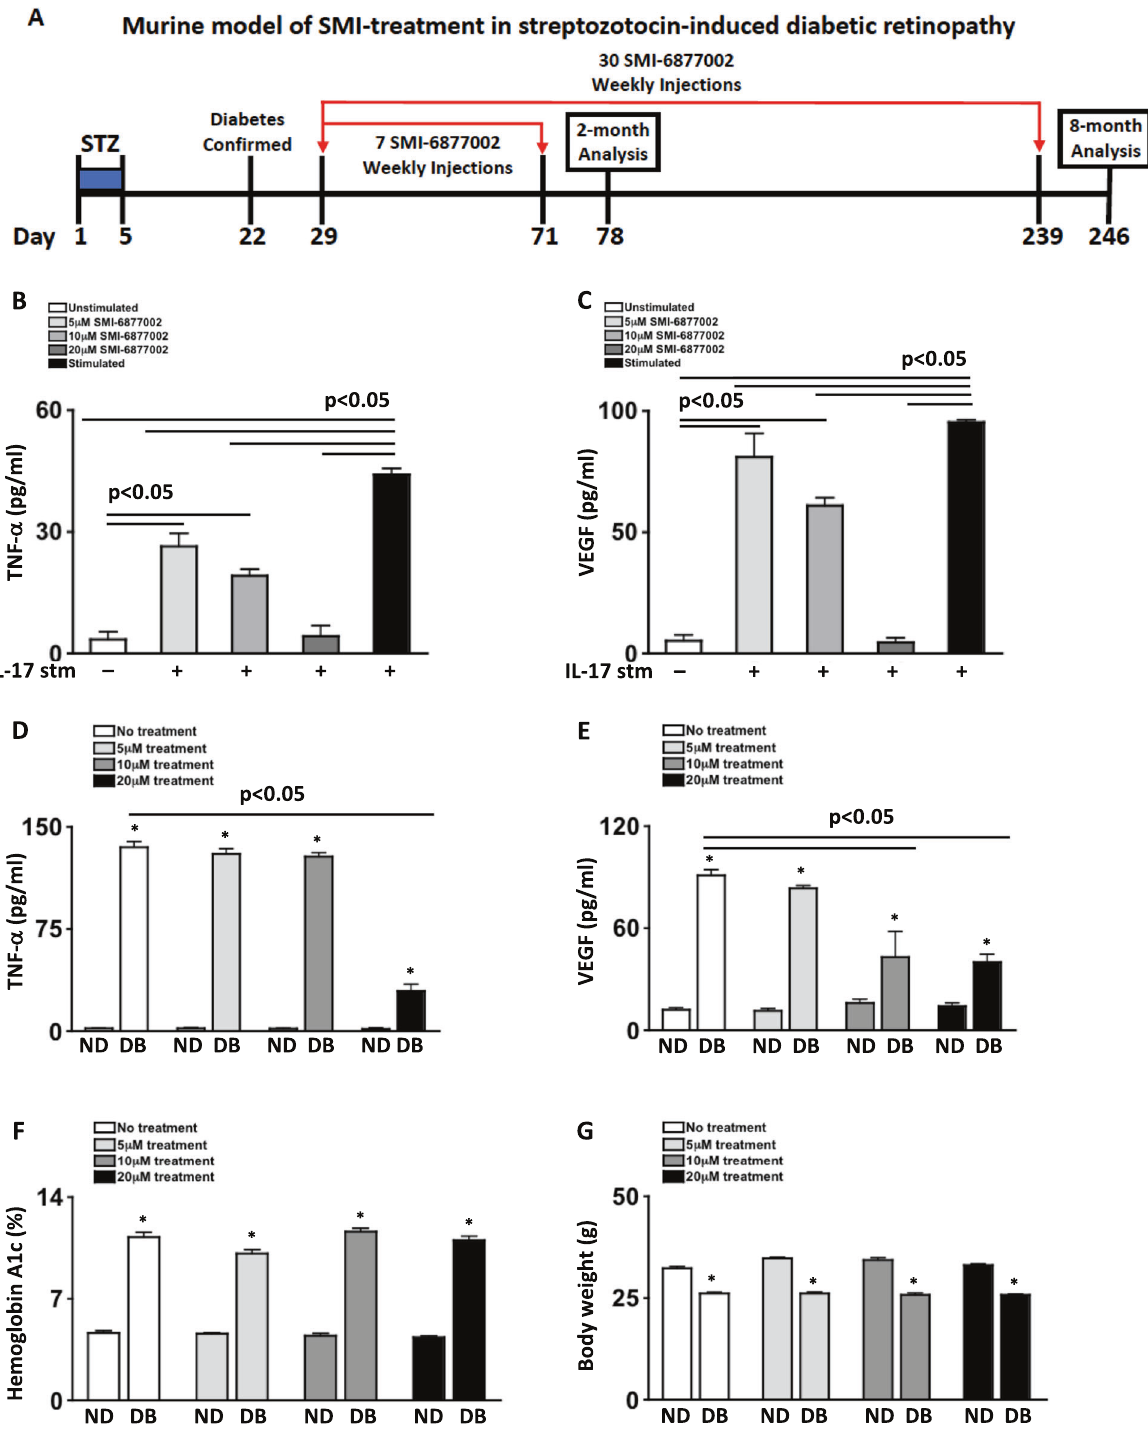
Fig. 1 In fl ammation in Muller glia and diabetic mice receiving SMI-6877002 treatments. A Schematic of diabetic retinopathy murine model and SMI-6877002 treatment regimen. Quanti fi cations of TNF- α ( B ) and VEGF ( C ) in supernatants of unstimulated (white), or IL-17A stimulated human Muller glia that were untreated (black), received 5 μ M (light grey), 10 μ M (mid-grey), or 20 μ M (dark grey) of SMI-6877002 ( n = 6/group). Levels of TNF- α ( D ) and VEGF ( E ) in retinas ( n = 3/group), and hemoglobin A1c ( F ) and body weight ( G ) of non-diabetic (ND) and STZ-diabetic (DB) mice that received no treatment (white), 5 μ M (light grey), 10 μ M (dark grey), or 20 μ M (black) of SMI-6877002 injections 1 time a week; 2-months after diabetes was con fi rmed. Error bars represent the SEM, * = p < 0.01; all p-values were equated using two-way ANOVA and unpaired student ’ s t-test. Data are representative of 2 separate